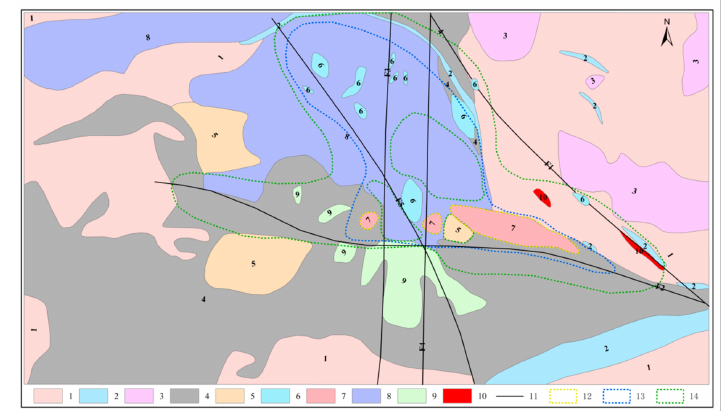
Figure 1. Geological map of the study area (after Mao et al., 2017) [34], 1. Clastic sedimentary